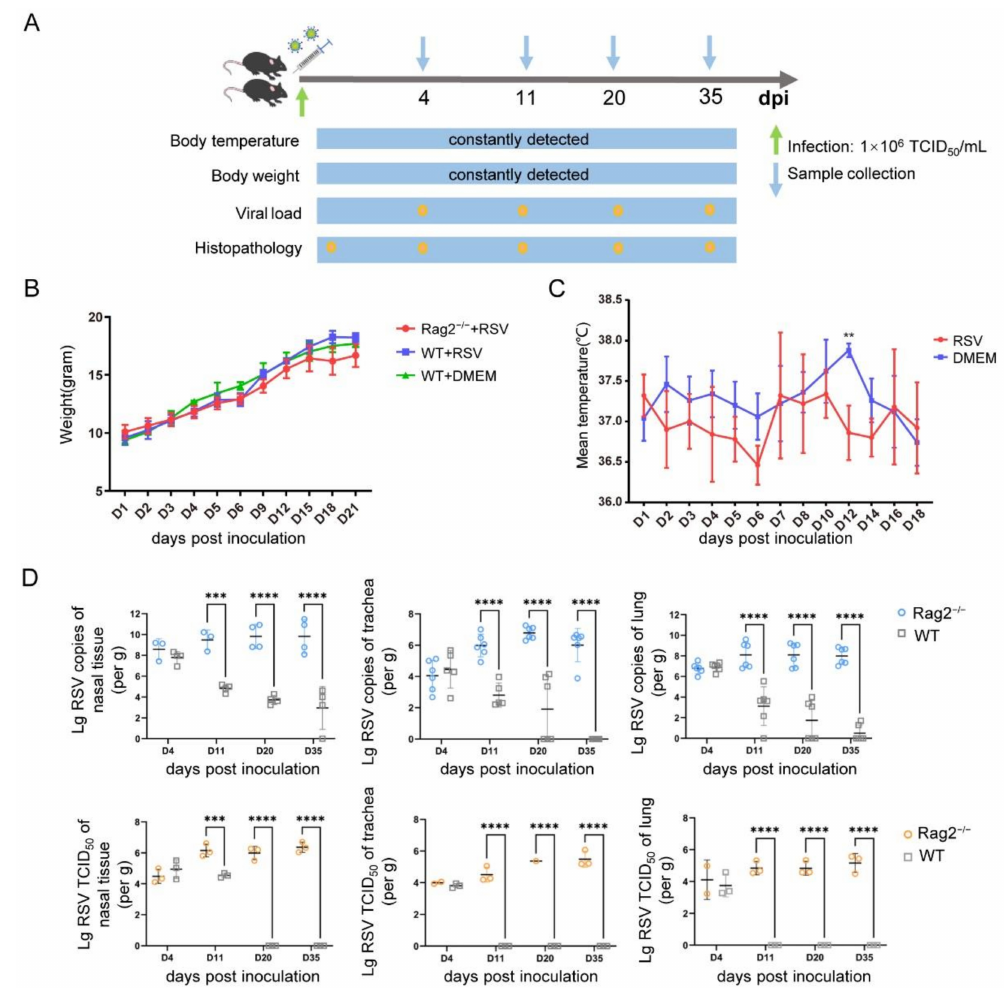
Figure 2. Establishment of an hRSV infection model using Rag2 − / − mice challenged intranasally. ( A ) Challenging and sampling schedules for establishment of the hRSV infectious model. ( B ) Body weight of Rag2 − / − mice (N = 4) and wild-type mice (N = 4) during the 21-day observation period post infection. ( C ) Rectal temperature during the 18-day observation period after challenging Rag2 − / − mice with hRSV (N = 5) or mock-challenge with DMEM (N = 5). ( D ) Total hRSV copies and viable hRSV loads in the target organs on 4, 11, 20, and 35 dpi according to RT-QPCR and TCID 50 . The statistical significance was evaluated by two-way ANOVA. ** p < 0.01, *** p < 0.001, **** p <